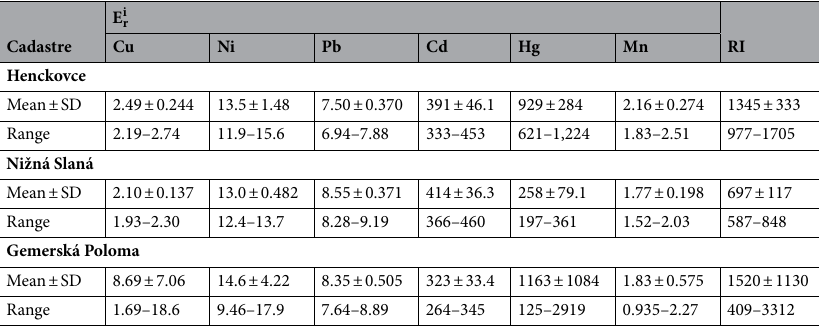
Table 3. Potential ecological risk factor ( E